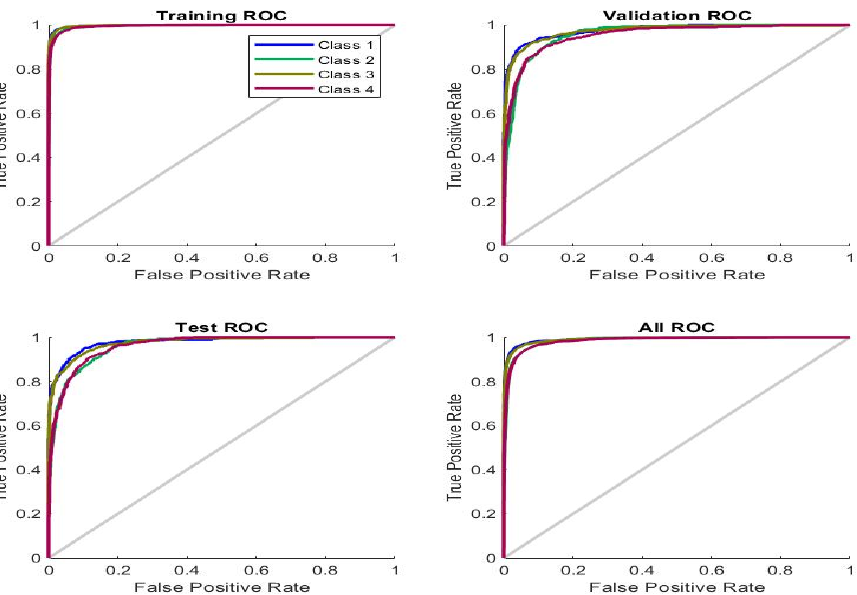
Figure 12. The ROC values for the microscopic blood samples dataset calculated using the ANN algorithm.